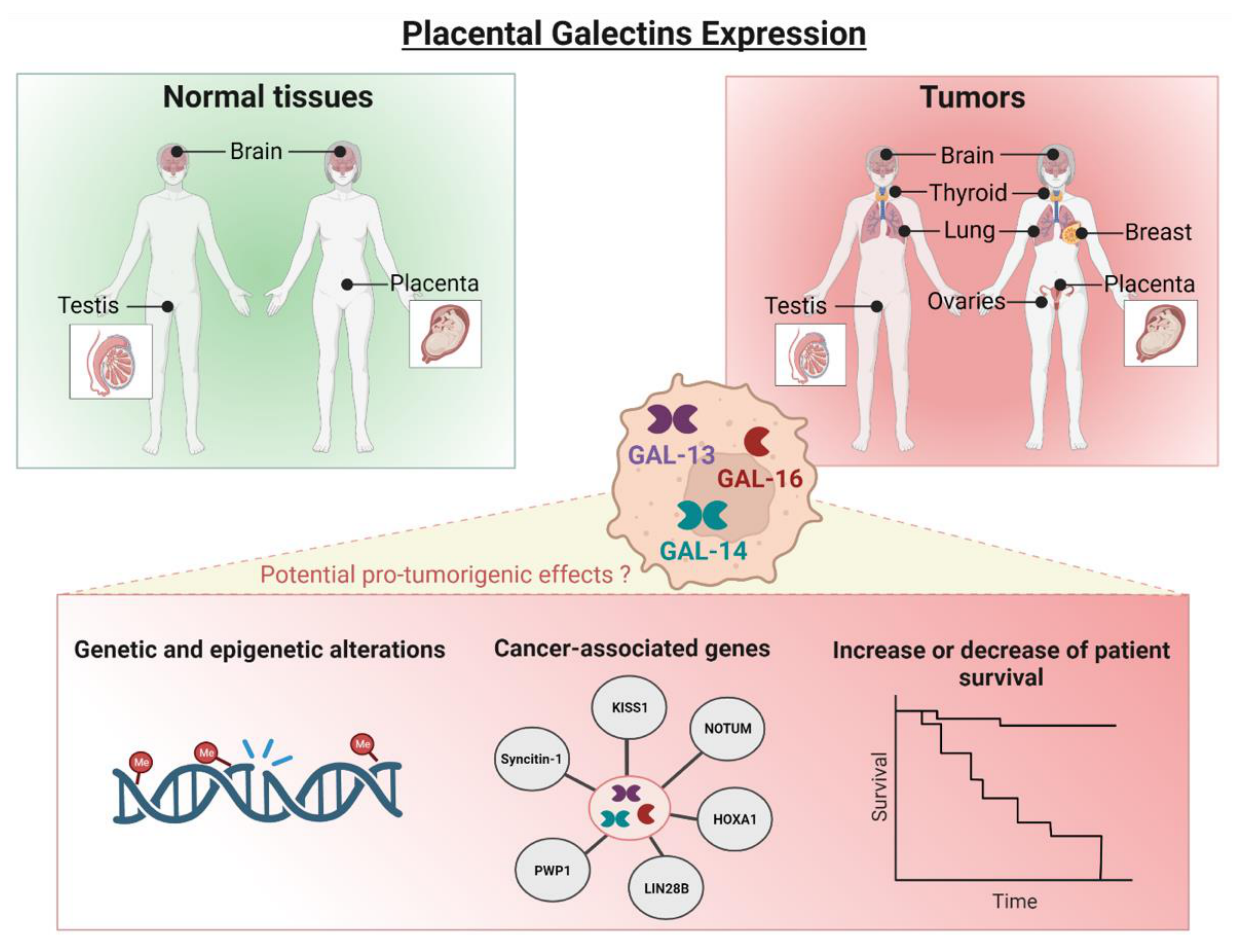
Figure 6. Recapitulative summary of the recent findings on placental galectins and potential future directions for further investigations.